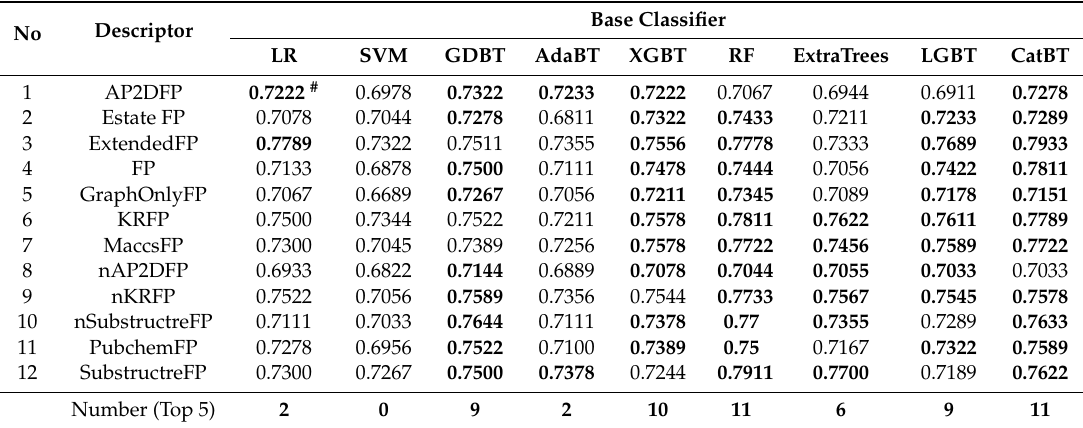
Table 1. Performance Comparison of Base Classifiers on the Whole Training Dataset.